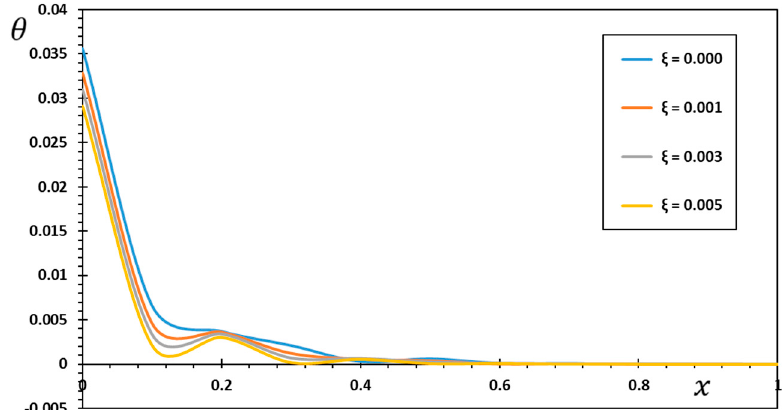
Figure 7. The dimensionless temperature, 𝜽 , under various nonlocal parameter 𝝃 values.